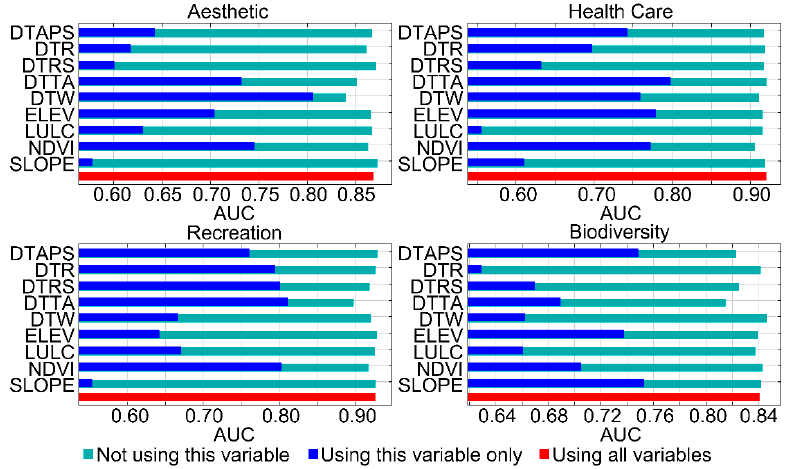
Figure 10. AUC of the jackknife test results of environmental variables.